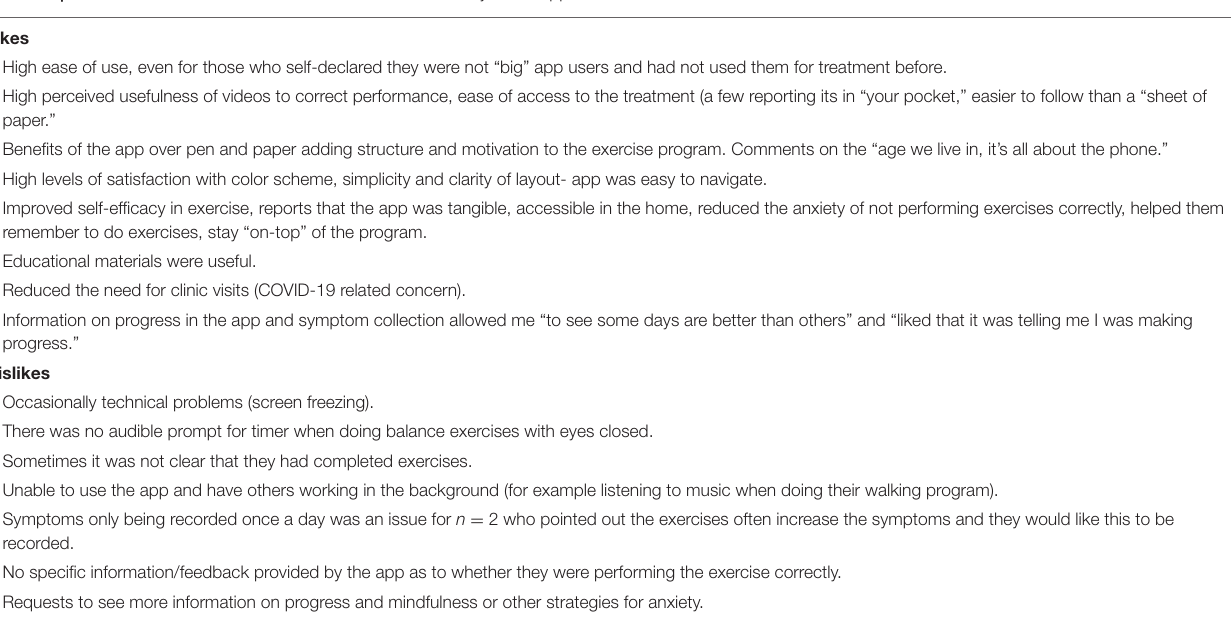
TABLE 3 | Results from the semi-structured interviews on the utility of the app in vestibular rehabilitation.